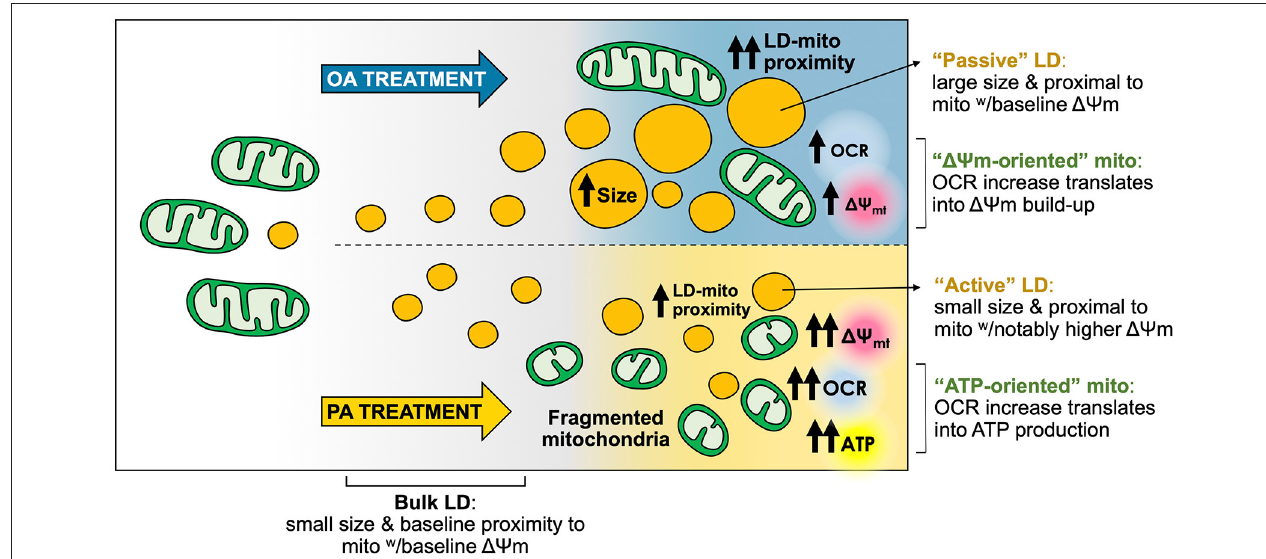
FIGURE 6 | Oleic and palmitic acids favor different lipid droplet and mitochondria sub-populations with distinct morphological and bioenergetic profiles in HepG2 cells. Both oleic acid (OA) and palmitic acid (PA) induce the formation of lipid droplets (LDs) in HepG2 cells. OA induces a steep nucleation process, followed by a steady growth of LDs. PA stimulates a moderate increase in the number of LDs, which maintain a small size. Moreover, while OA does not affect mitochondrial morphology, PA elicits fragmentation of the mitochondrial network. Both treatments boost mitochondrial respiration (OCR), but with different outcomes. OA mainly heightens the overall transmembrane potential of the mitochondrial network ( 1 ψ m-oriented network). On the other hand, PA treatment favors ATP generation (ATP-oriented network). LD-mitochondria physical proximity increases upon treatment with either fatty acid. OA evokes higher levels of LD-mitochondria interaction compared to PA. However, LDs from OA-treated cells are rather “passive”, as their larger size associates with lower- 1 ψ m mitochondria, compared to PA. LDs from PA-treated cells are apparently more “active”, as they are smaller and interact with higher- 1 ψ m mitochondria, which is concomitant with increased ATP